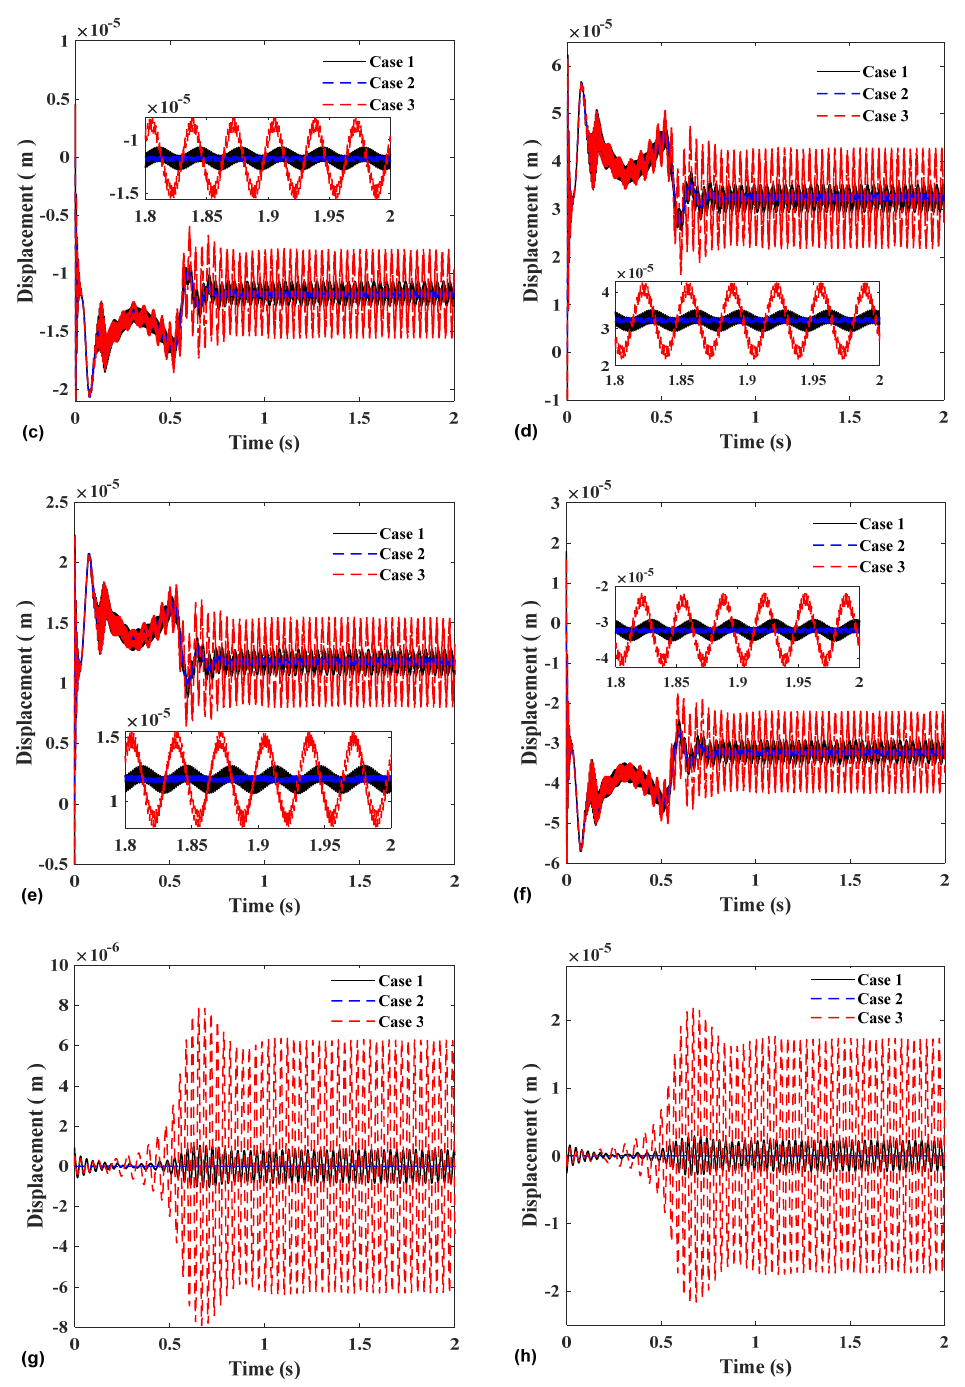
Figure 13. ( a ) Gear1 − 3 mesh force; ( b ) Gear2 − 3 mesh force; ( c ) Gear 1 X − direction; ( d ) Gear 1 Y − di- Y -direction; ( e ) Gear 2 X -direction; ( f ) Gear 2 Y -direction; ( g ) Gear 3 X -direction; and ( h ) Gear 3 rection; ( e ) Gear 2 X − direction; ( f ) Gear 2 Y − direction; ( g ) Gear 3 X − direction; and ( h ) Gear 3 Y − di- Y rection.